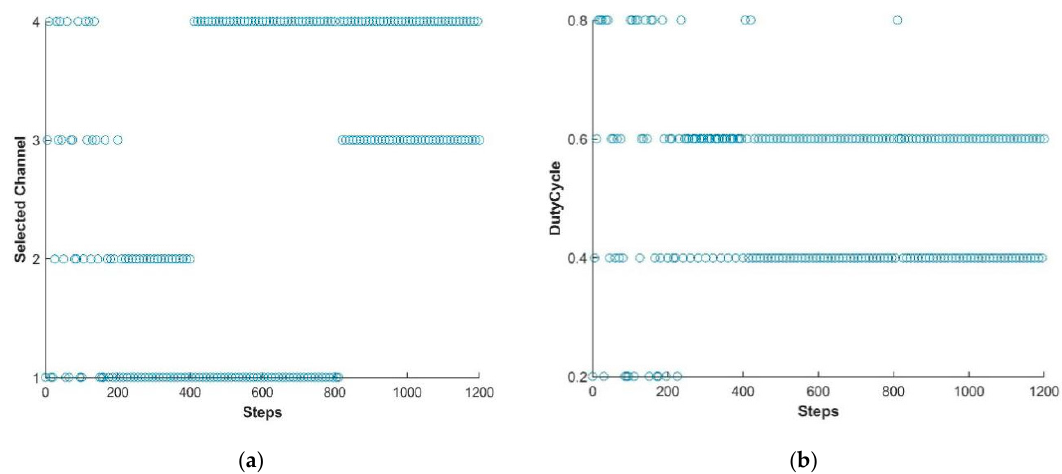
Figure 6. LTE-U BS with COT method. ( a ) Channel selection vs number of steps; ( b ) Dutycycle selection vs number of steps.